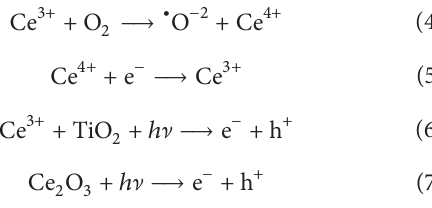
2.25 eV also contributed to this increase in